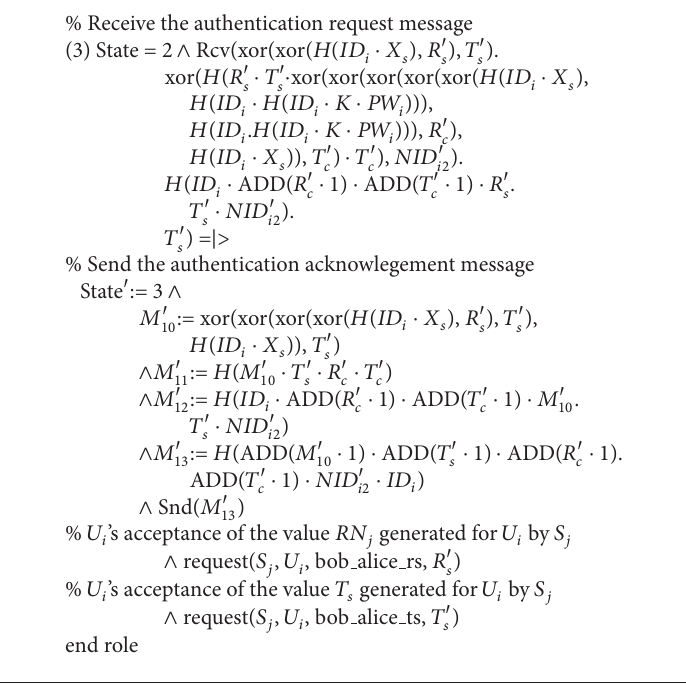
Algorithm 3: Role specification in HLPSL for the user 𝑈 𝑖 of our scheme.